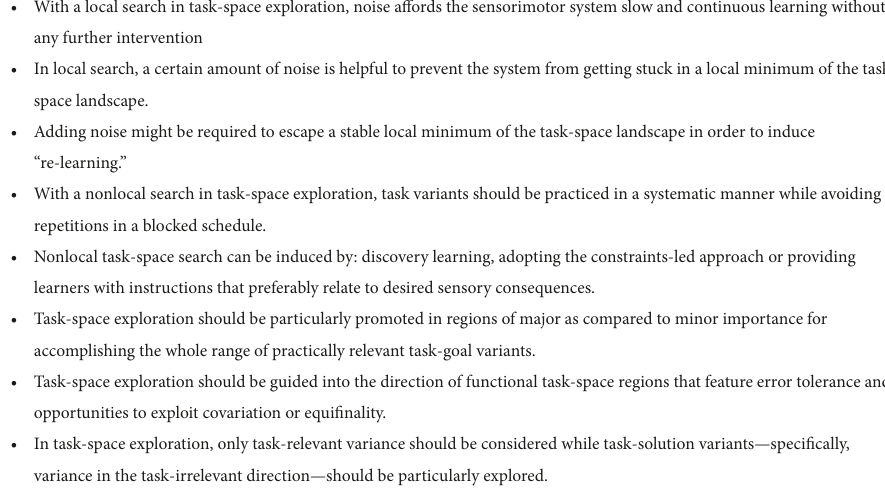
TABLE 1 The role of variance for different sensorimotor-learning mechanisms (in brackets: chapter number). Task-space exploration